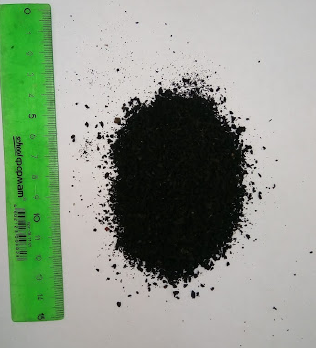
Figure 3. Rubber crumb of improved grain composition No.